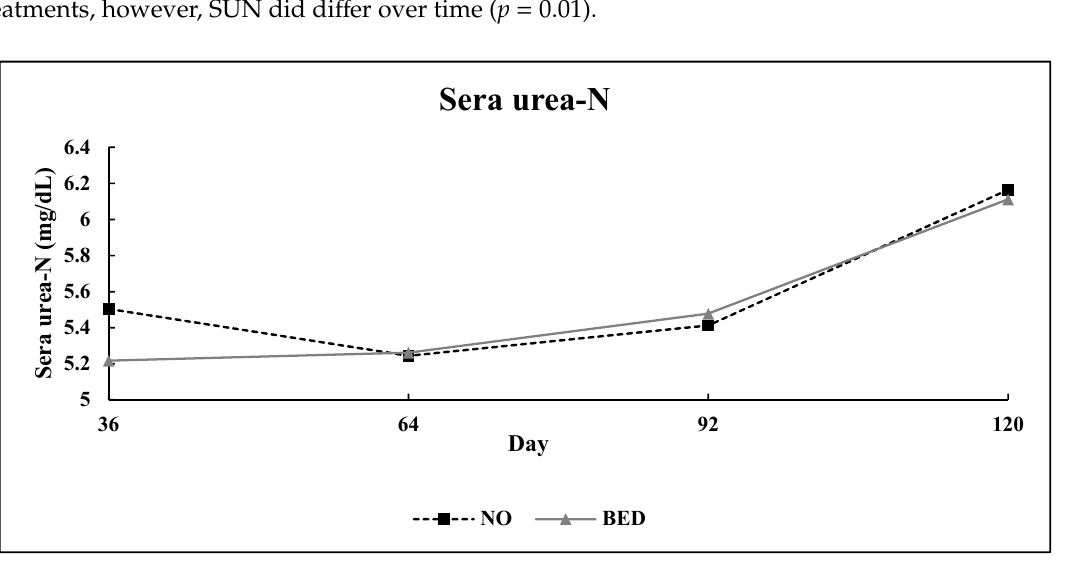
Figure 3. Experiment 1: Effect of bedding treatment on serum concentration of urea-N (SUN) in finishing steers ( n = 15 pens / treatment; pooled bed × day SEM (Standard error of the mean) = 0.23). Treatments were: No bedding applied (NO) and 1.8 kg (as-is basis) of wheat straw bedding/steer·d − 1 (BED). Blood was collected and harvested as sera on days 36, 64, 92, and 120. No bed × day interaction ( p = 0.24) was detected for serum concentration of IGF-I (Figure 4). Bedding treatment resulted in a 17% increase ( p = 0.01) in sera IGF-I. Circulating sera IGF-I also differed over time ( p = 0.01).